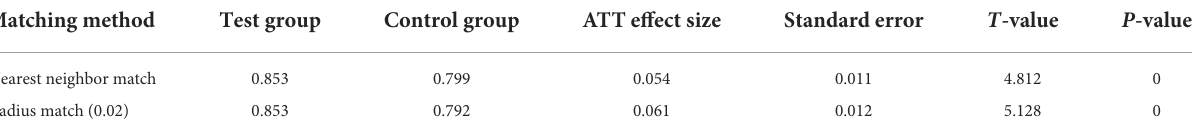
TABLE 6 Propensity score matching estimation